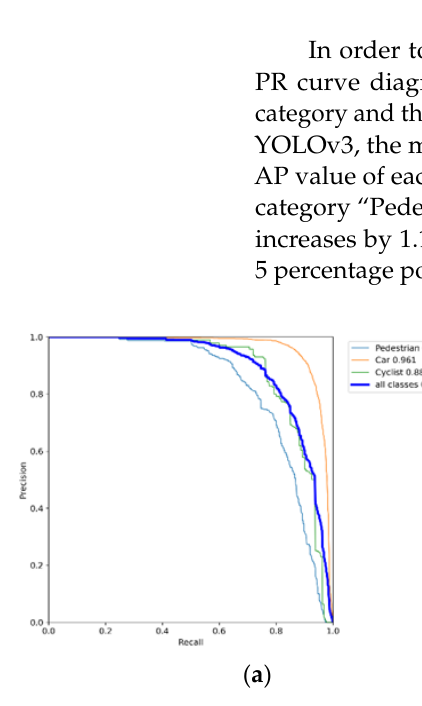
Figure 5. The PR curve diagram of YOLOv3 and YOLO-MXANet on the KITTI dataset. ( a ) YOLOv3. ( b )